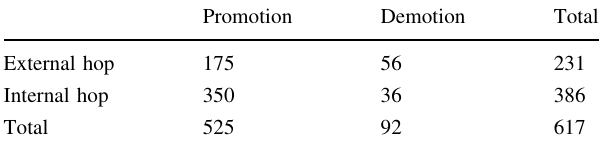
Table 6 Hop classification statistics for Hong Kong